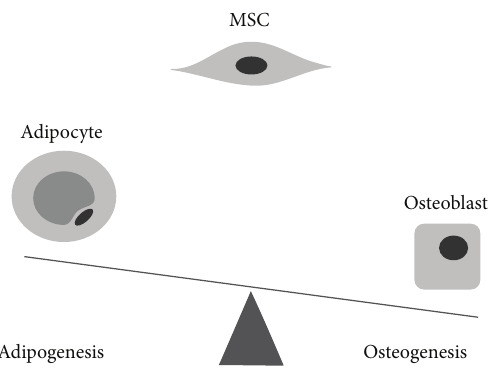
Figure 2: Theoretical inverse relationship between osteogenic and adipogenic programming. Multiple signaling pathways have been demonstrated to preferentially induce osteogenic programming at the expense of adipogenesis, or vice versa. In this regard, the differentiation of an MSC into either an adipocytic or osteoblastic phenotype can be theorized as a seesaw, where induction of one lineage comes at the expense of the other. However, numerous exceptions exist to this